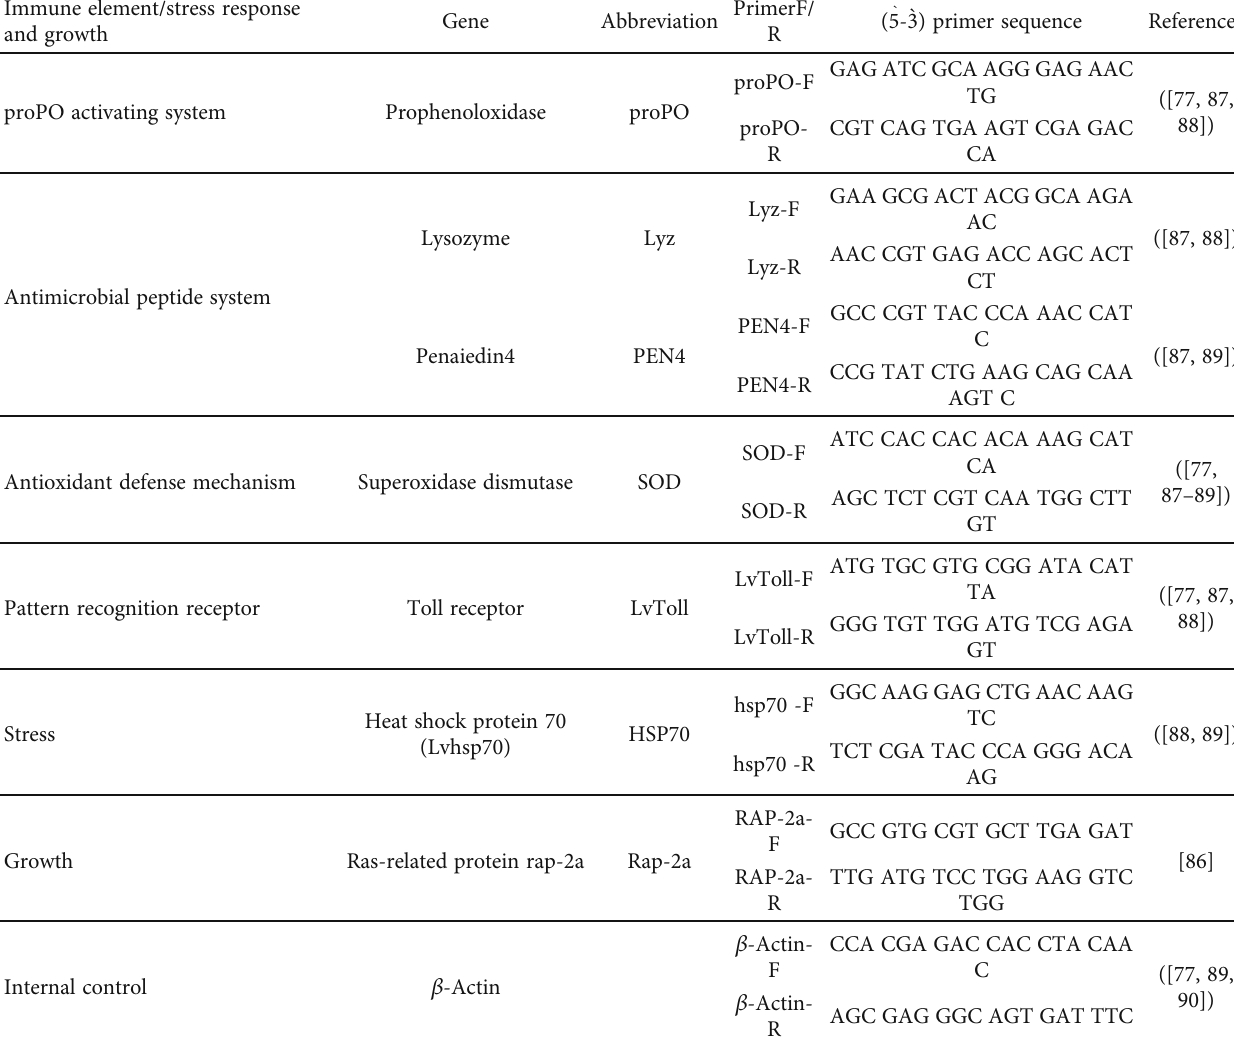
Table 2: Sequences of primers submitted for RT-qPCR to assess immunological, stress, and growth state of shrimp, L. vannamie. Immune element/stress